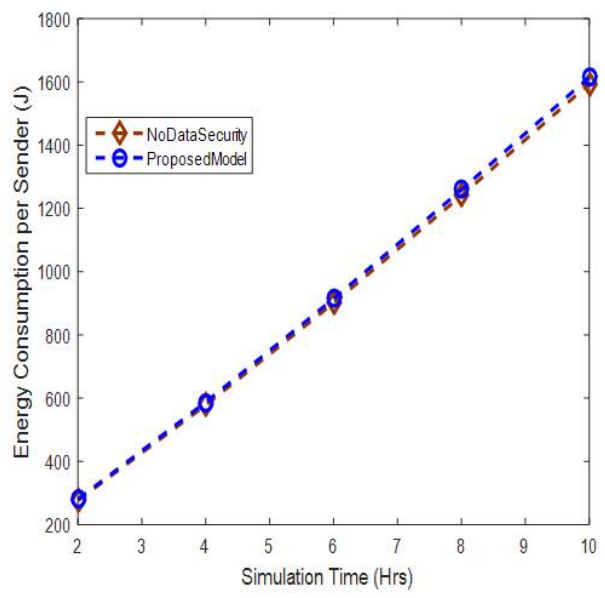
Figure 11. Energy consumption per sender versus simulation time.